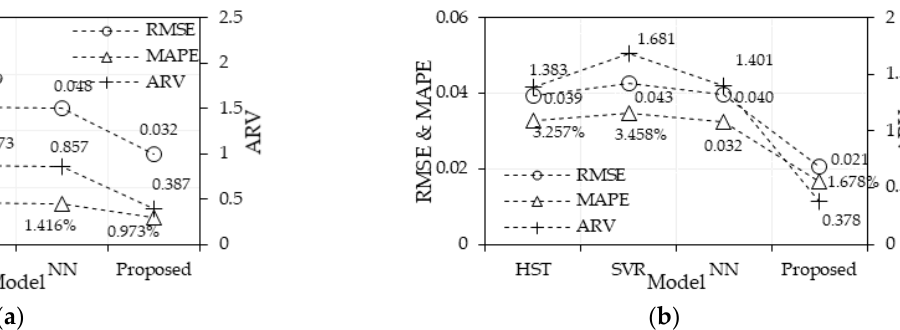
Figure 13. Evaluation metrics for each model. The results correspond to the testing period. ( a ) Direction along the river, ( b ) Vertical direction.